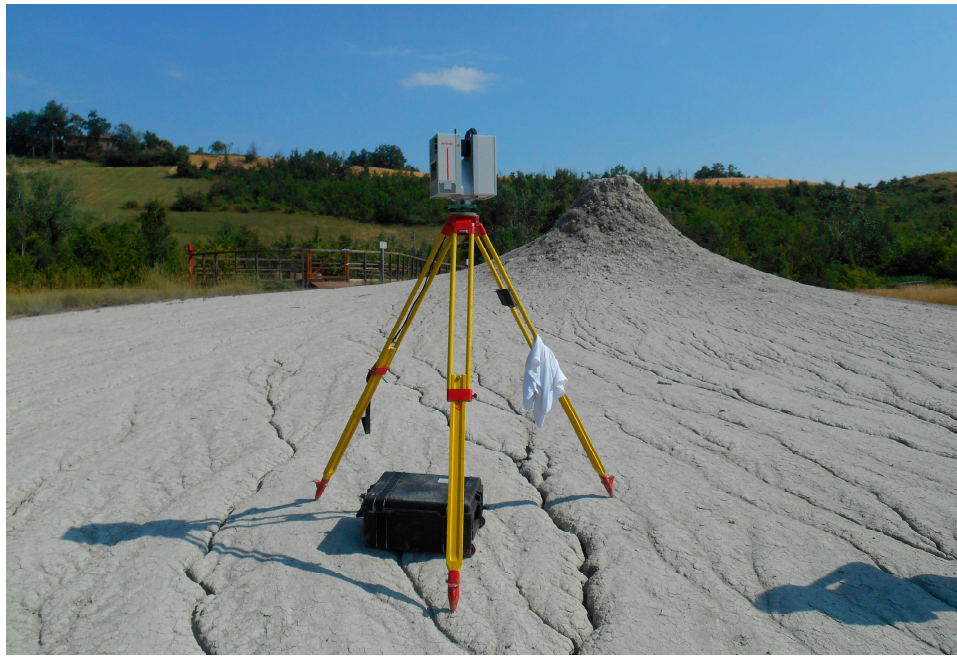
Figure 2. The Leica HDS7000 laser scanner during the operations on field. Photo: Santagata T.